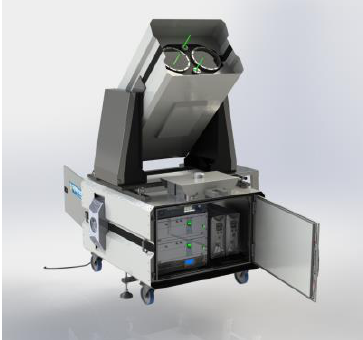
Figure 4: Conceptual design for the EVE mobile li- dar. The system measurements are based on two la- sers emitting circularly and linearly polarized radia- tion at 355nm and two receiving telescopes. It will